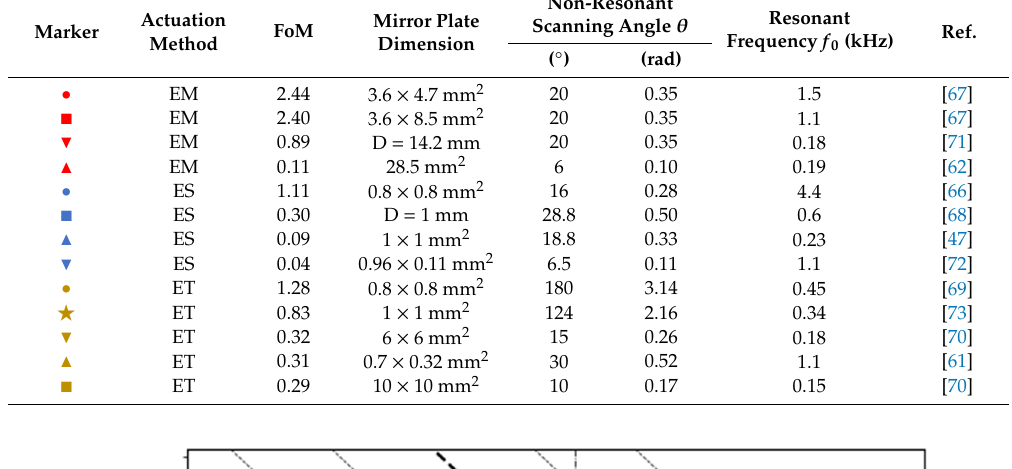
Table 3. The FoMs of 1D non-resonant scanning MEMS mirrors.